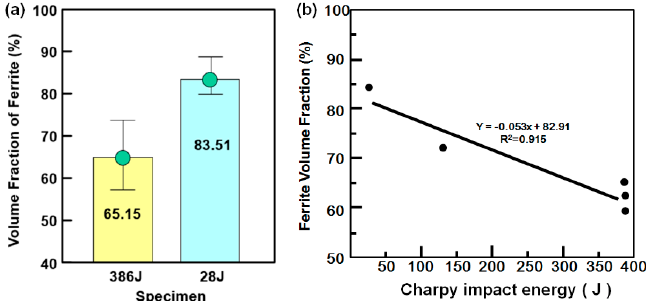
Mn content of matrix at 0.3%